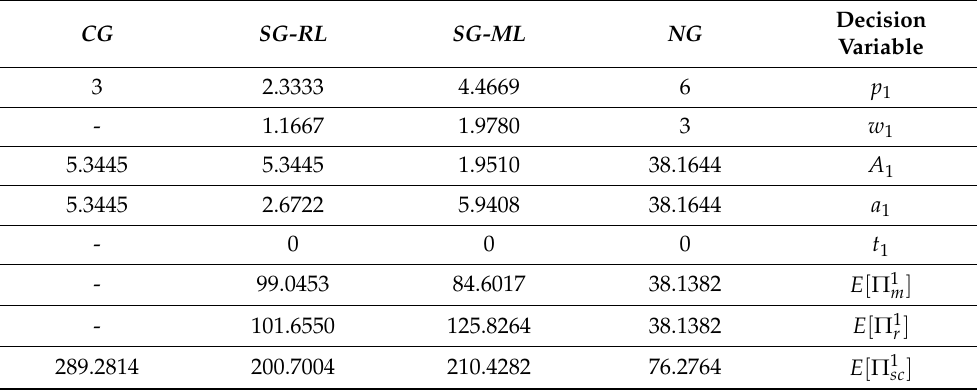
Table 3. The results for the numerical example 1 in the first model.